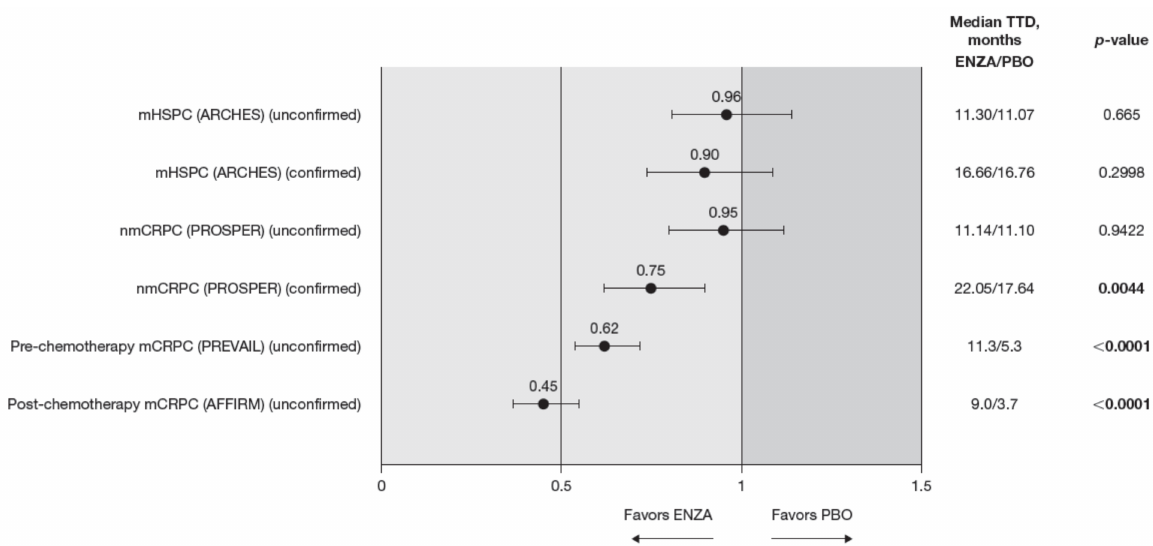
Figure 7. FACT-P total score TTD. To meet criteria for “confirmed” time to first deterioration, the initial (unconfirmed) report of deterioration had to be verified at the next consecutive study visit. Abbreviations: ENZA: Enzalutamide; FACT-P: Functional Assessment of Cancer Therapy—Prostate; mCRPC: Metastatic castration-resistant prostate cancer; mHSPC: Metastatic hormone-sensitive prostate cancer; nmCRPC: Non-metastatic castration-resistant prostate cancer; PBO: Placebo; TTD: Time to